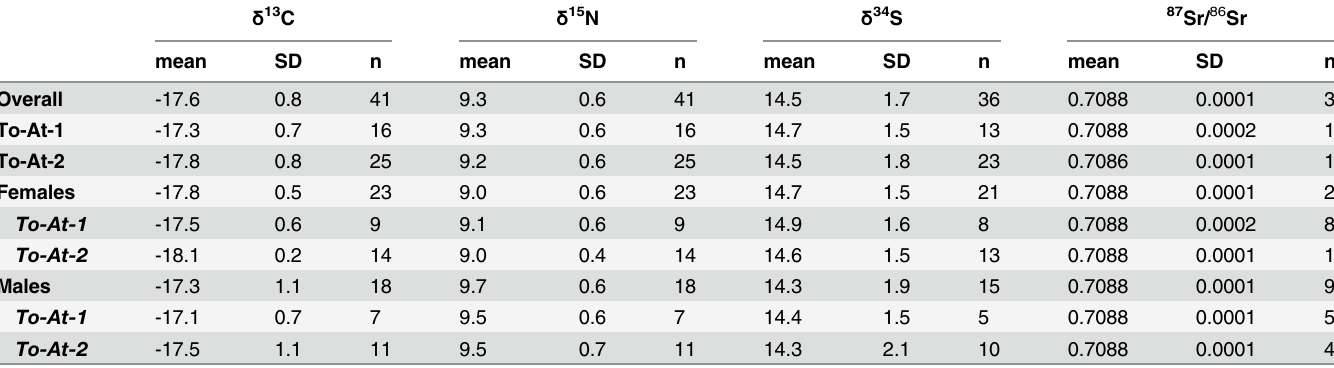
Table 2. Summary statistics of isotopic results for the `Atele humans by sex and burial mound. δ 13